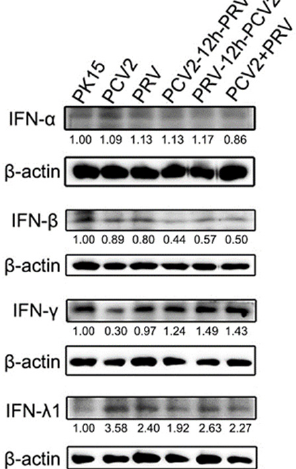
Figure 2. Coinfection of PCV2 and PRV modulates IFNs. Western blotting was performed using Interferon alpha 1 Antibody, Interferon beta/IFNB, IFN- γ , IL28/29 (H-1), and Anti- β -Actin Antibody as primary antibodies, respectively. HRP-labeled Goat Anti-mouse IgG (H+L) and HRP-labeled Goat Anti-rabbit IgG (H+L) were used as the secondary antibody. β -actin was used as a control. The average expression level of the target protein in each group is shown below each lane. The protein amount of the PK-15 group is set to 1, and the values of other groups are the ratio with the PK-15 group. Unprocessed original images can be found in Supplementary Figure S1.